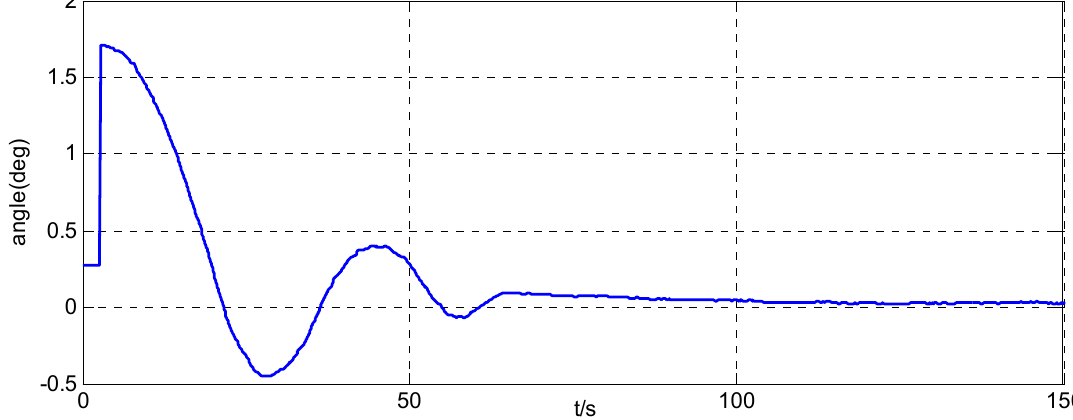
Figure 10. Angle around the z-axis of the simulator when θ z ( 0 ) = 1.7 ◦